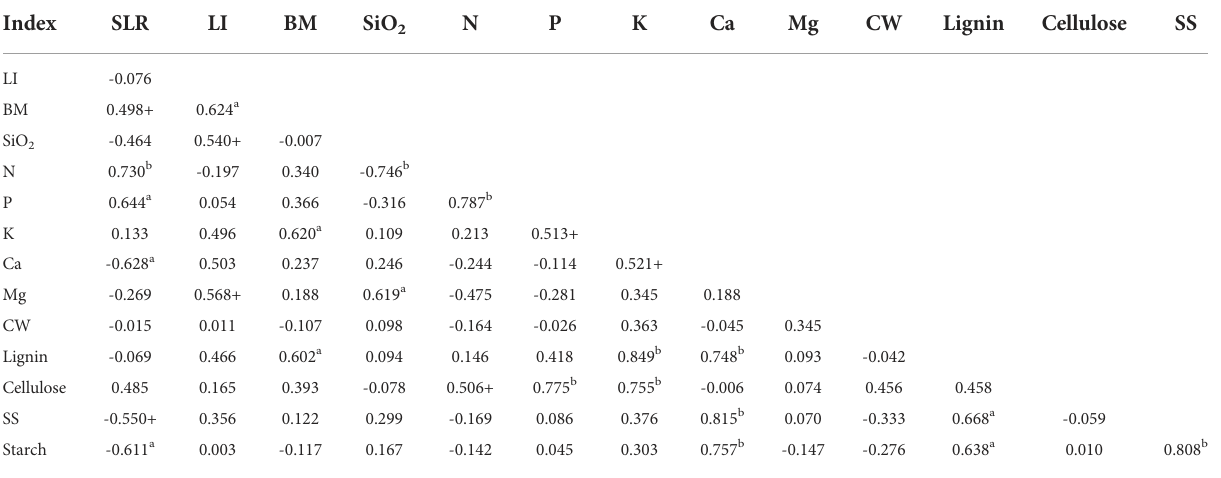
TABLE 5 Relationships among the chemical indicators of rice stem under soil-testing formula fertilization using organic fertilizer (STFFOF) for 11 years. Index